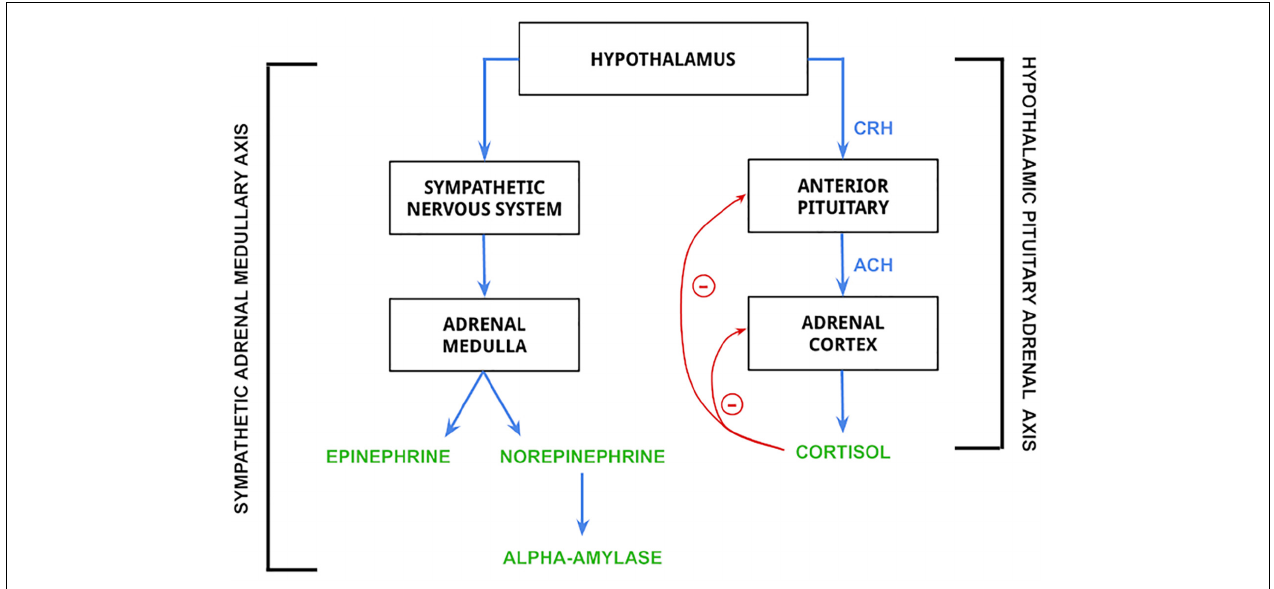
FIGURE 1 | Mechanism of release for epinephrine, norepinephrine, alpha-amylase, and cortisol. Biomarkers in the figure are controlled by the hypothalamus. The hypothalamic pituitary adrenal (HPA) axis is activated by hypothalamic release of corticotropin-releasing hormone (CRH), which stimulates the secretion of adrenocorticotropin hormone (ACH) from the anterior pituitary gland. ACH then acts on the adrenal cortex to stimulate the release of cortisol (Lanoix and Plusquellec, 2013; Antoun et al., 2017), which is regulated by negative feedback loops to both the anterior pituitary and adrenal cortex. The sympathetic adrenal medullary (SAM) axis is activated by the hypothalamus to stimulate a sympathetic nervous system response, which then stimulates the adrenal medulla to produce epinephrine and norepinephrine (Antoun et al., 2017). The release of norepinephrine is then responsible for the synthesis and release of alpha-amylase (Sawami et al.,